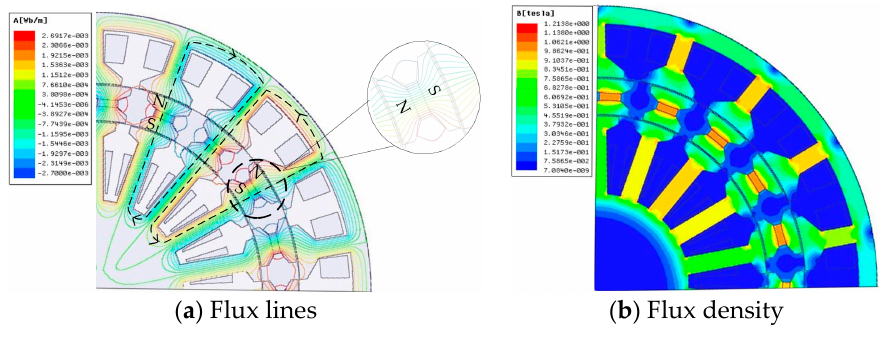
Figure 4. Flux distribution of DSSR-PMG.